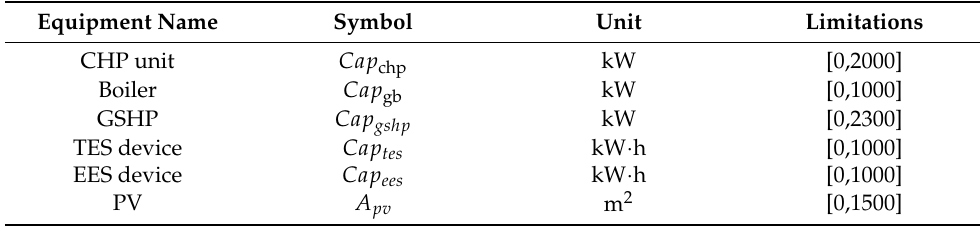
Figure 4. Outdoor parameters and building load under design conditions: ( a ) Hourly outdoor design temperature and solar radiation intensity in summer; ( b ) Cooling, heating, and electric load on the design day. Table 6. Optimization range of equipment